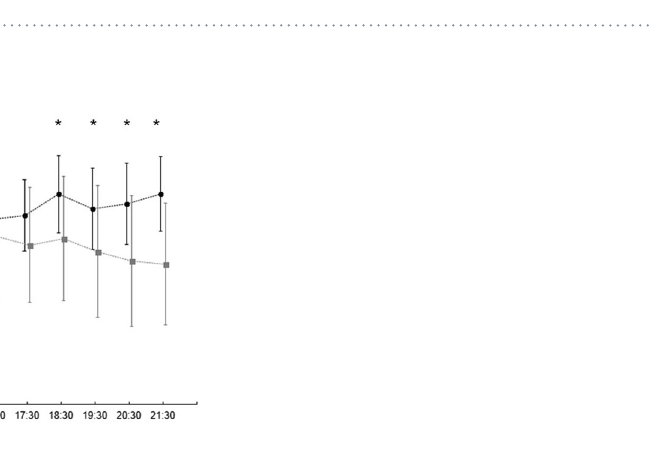
Figure 1. Karolinska Sleepiness Scale scores (1–9, with 9 = maximum sleepiness; mean ± 95% CI) over the waking hours of the day in PER3 5 /PER3 5 (black circles, n = 59), PER3 4 /PER3 5 (light grey squares, n = 137) and PER3 4 /PER3 4 (dark grey diamonds, n = 135) subjects. Effect of genotype: p = 0.195, time: p < 0.001, genotype * time: p = 0.029.